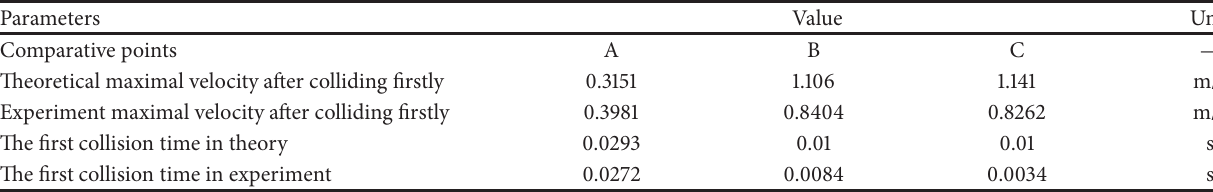
Table 5: Comparison analysis between the velocities of the A, B, and C